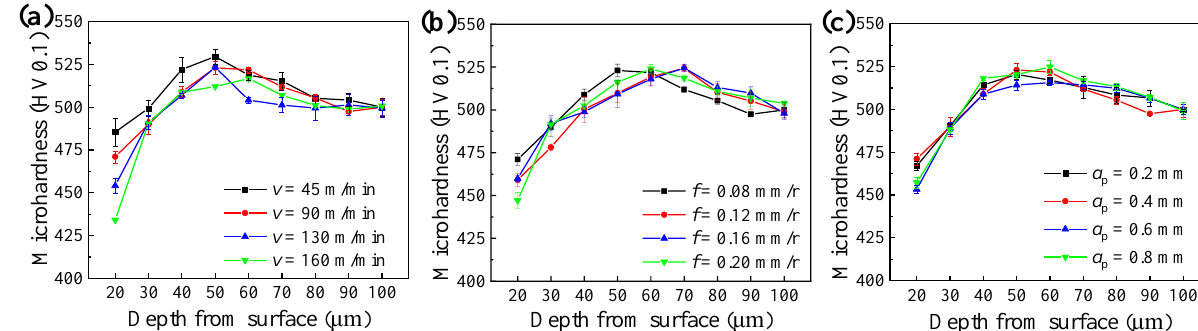
Figure 6. Microhardness of samples machined under different cutting parameters: ( a ) cutting speed, ( b ) feed rate, and ( c ) cutting depth.